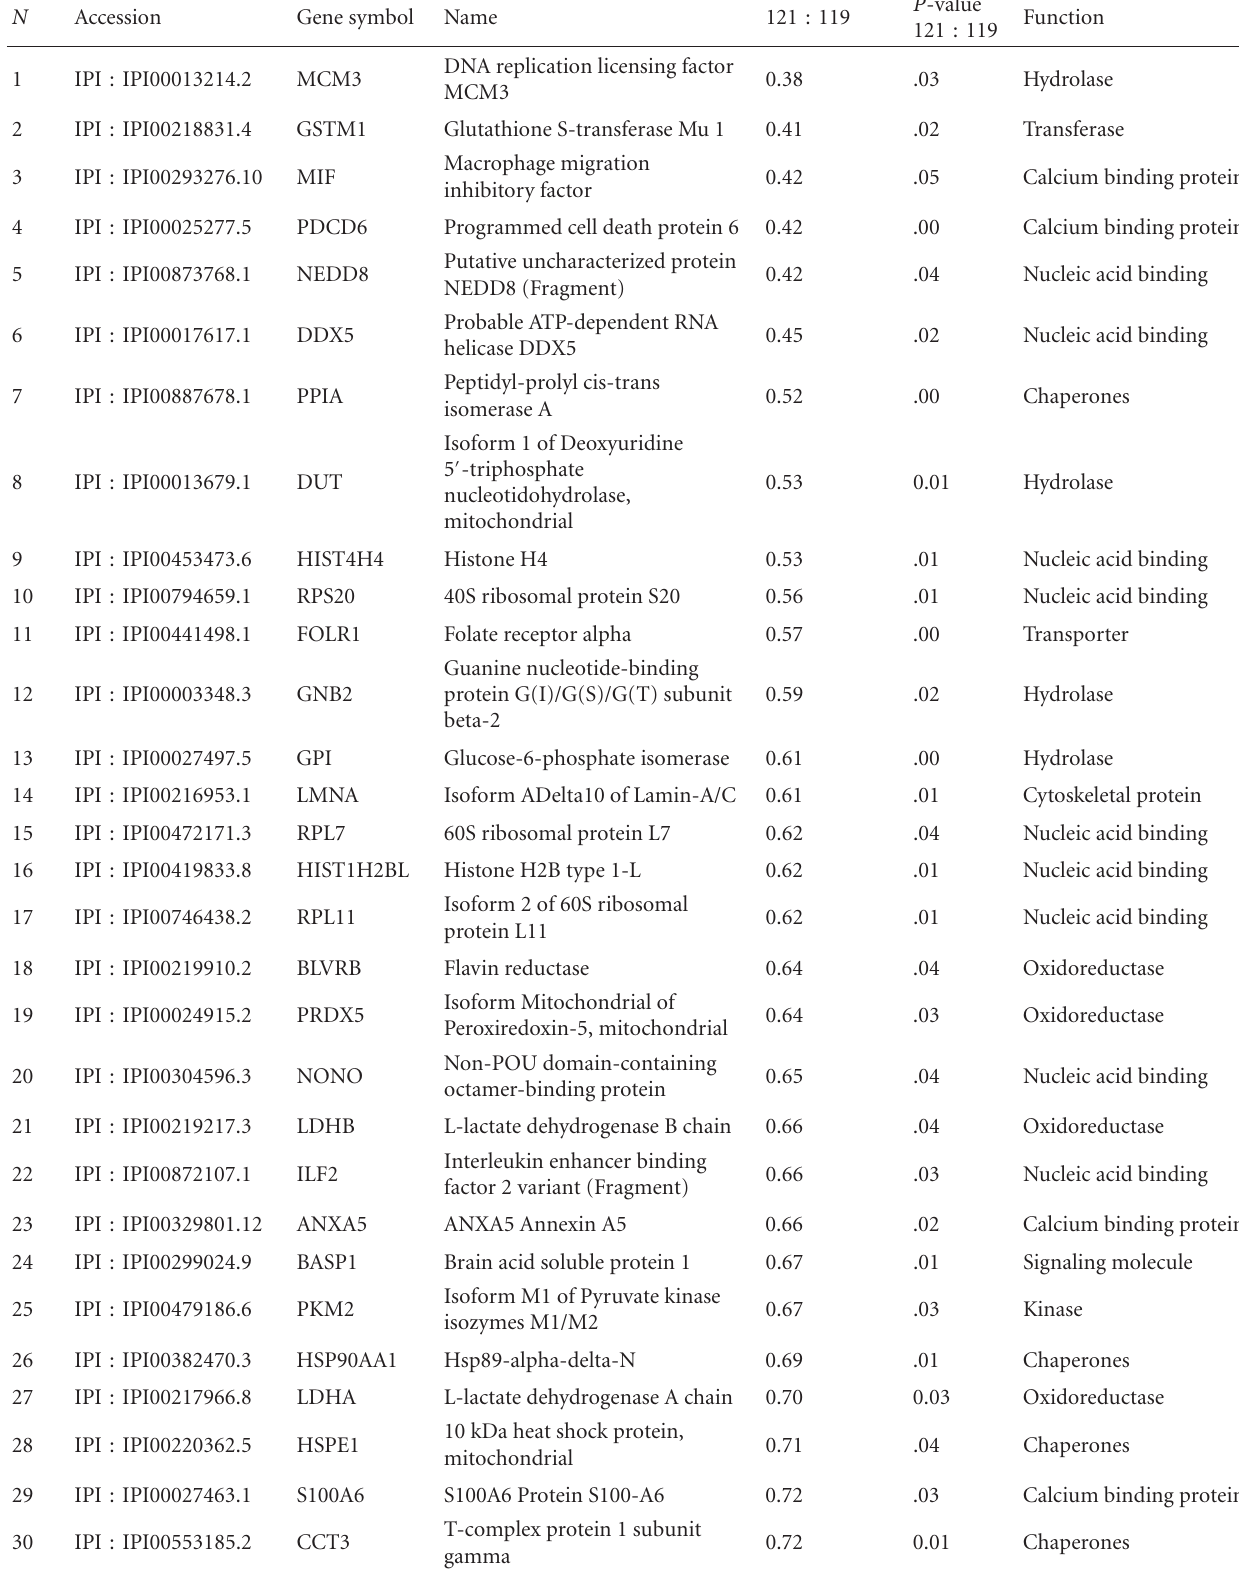
Table 1: iTRAQ analysis of di ff erentially expressed proteins between vincristine-resistant SGC7901/VCR (iTRAQ 121) and SGC7901 (iTRAQ